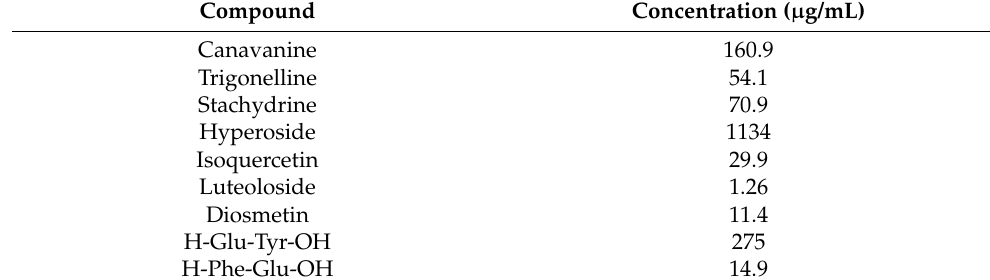
Figure 5. Lengths of the shoots and roots of barley seedlings after treatment with the pure main components of the alfalfa seed exudates after 10 days at a concentration of 150 µg/mL (except for luteoloside, which was employed at 20 µg/mL). Di ff erent lowercase le tt ers on the top of the column for each treatment indicate signi fi cant di ff erences with p < 0.05 using Tukey’s test. The mean value corresponds to the average value of forty seedlings. The error bar corresponds to the standard de- viation.